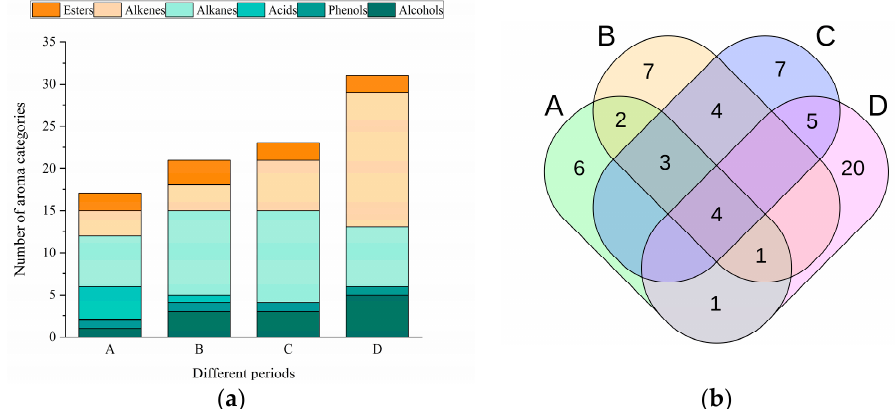
Figure 2. ( a ) Classification of VOCs detected in cabya fruit at each of the four developmental periods; ( b ) Venn diagram summarizing cabya fruit aroma component differences across developmental